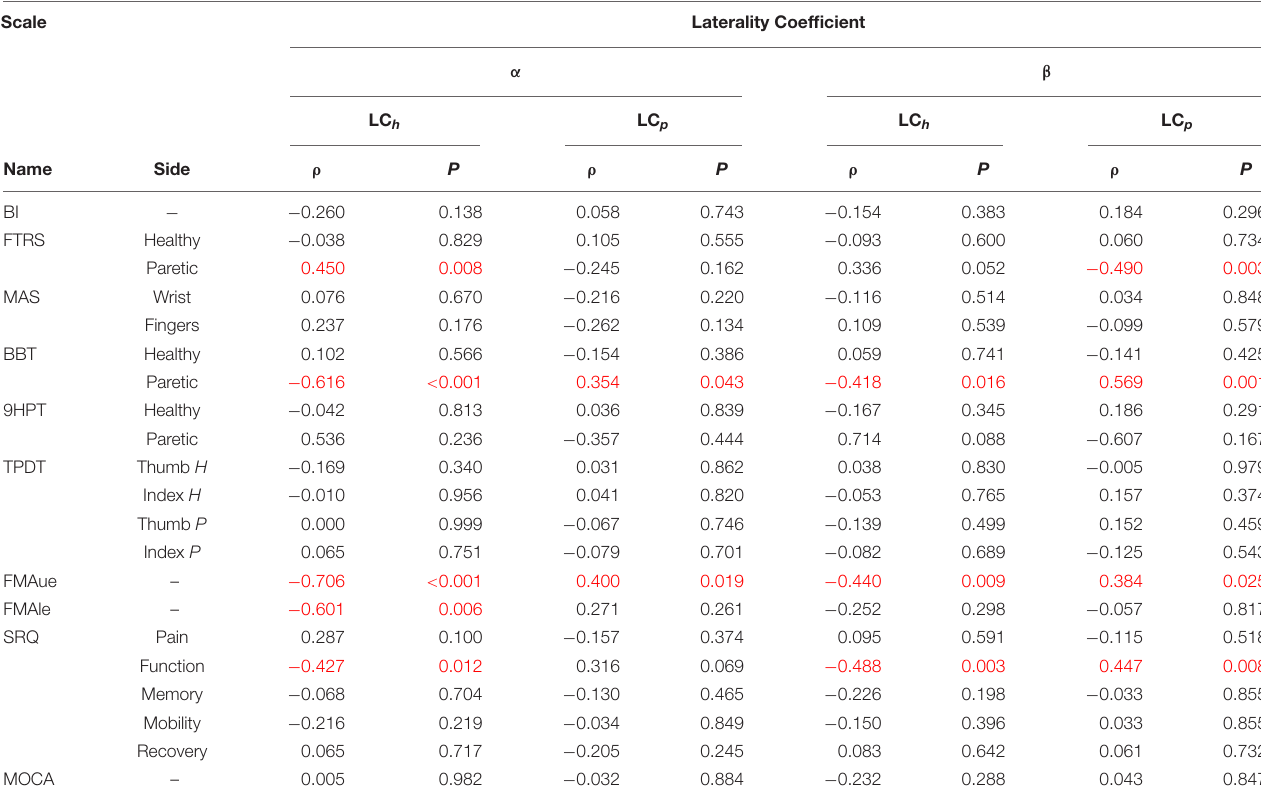
TABLE 5 | Significant correlations between LC and functional scales using Spearman Correlation are colored red.